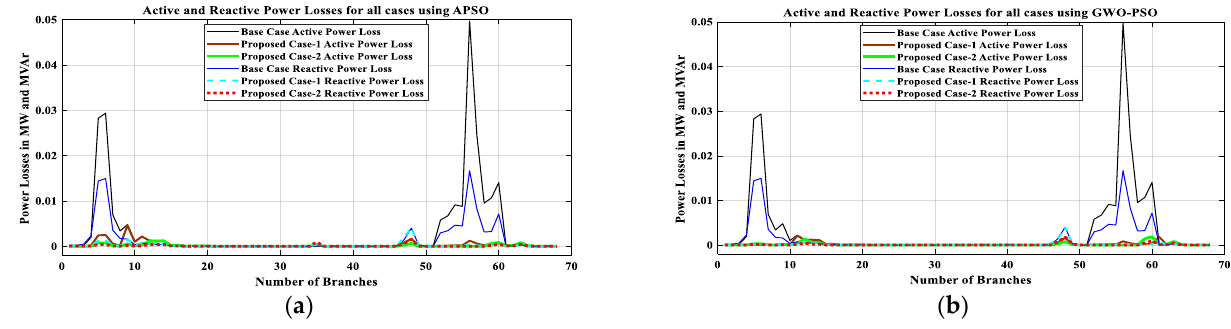
Figure 23. Cumulative representation of active and reactive power loss for all cases of 69-bus RDN; ( a ) APSO, ( b ) GWO-PSO.